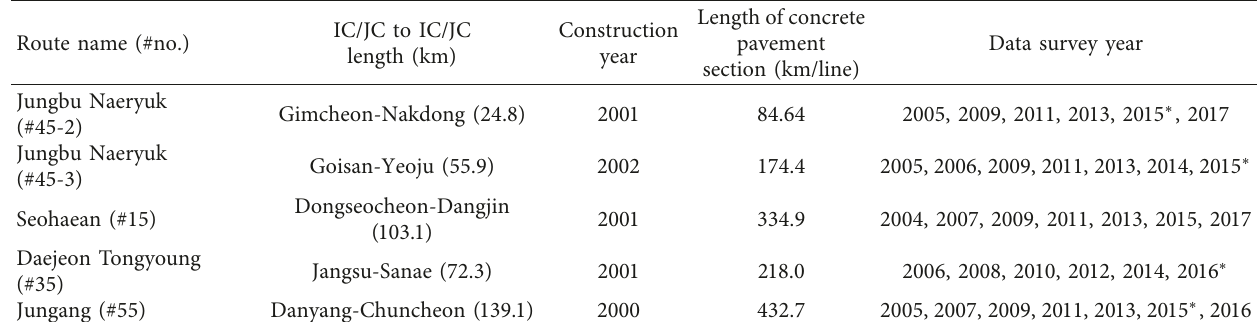
Table 5: Summary of concrete pavement sections built in 2000s for performance data analysis. Route name